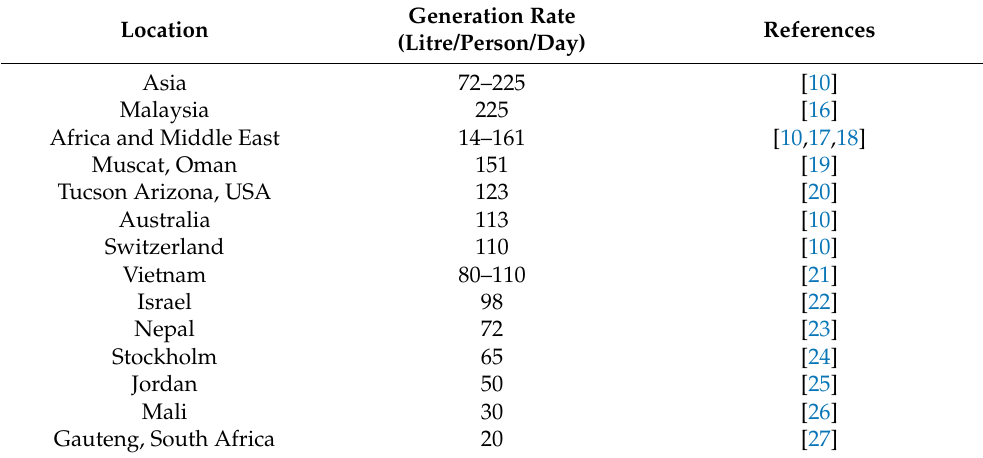
Table 1. Greywater generation reported in different countries.